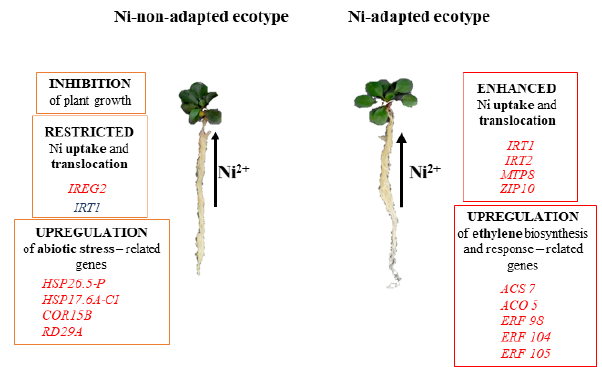
Figure 5. Model of distinct Ni accumulation properties and gene expression patterns in non- and metallicolous ecotypes of Noccaea goesingensis. Depicted genes for each ecotype are either upregulated (red) or downregulated (blue). The thickness of the arrow indicates the Ni uptake.